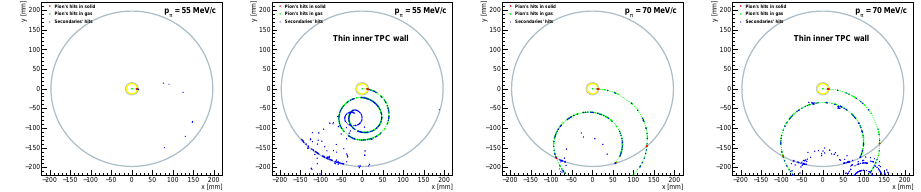
Figure 8. Cross-section of Inner Tracker based on TPC with hits, left by pion and secondary